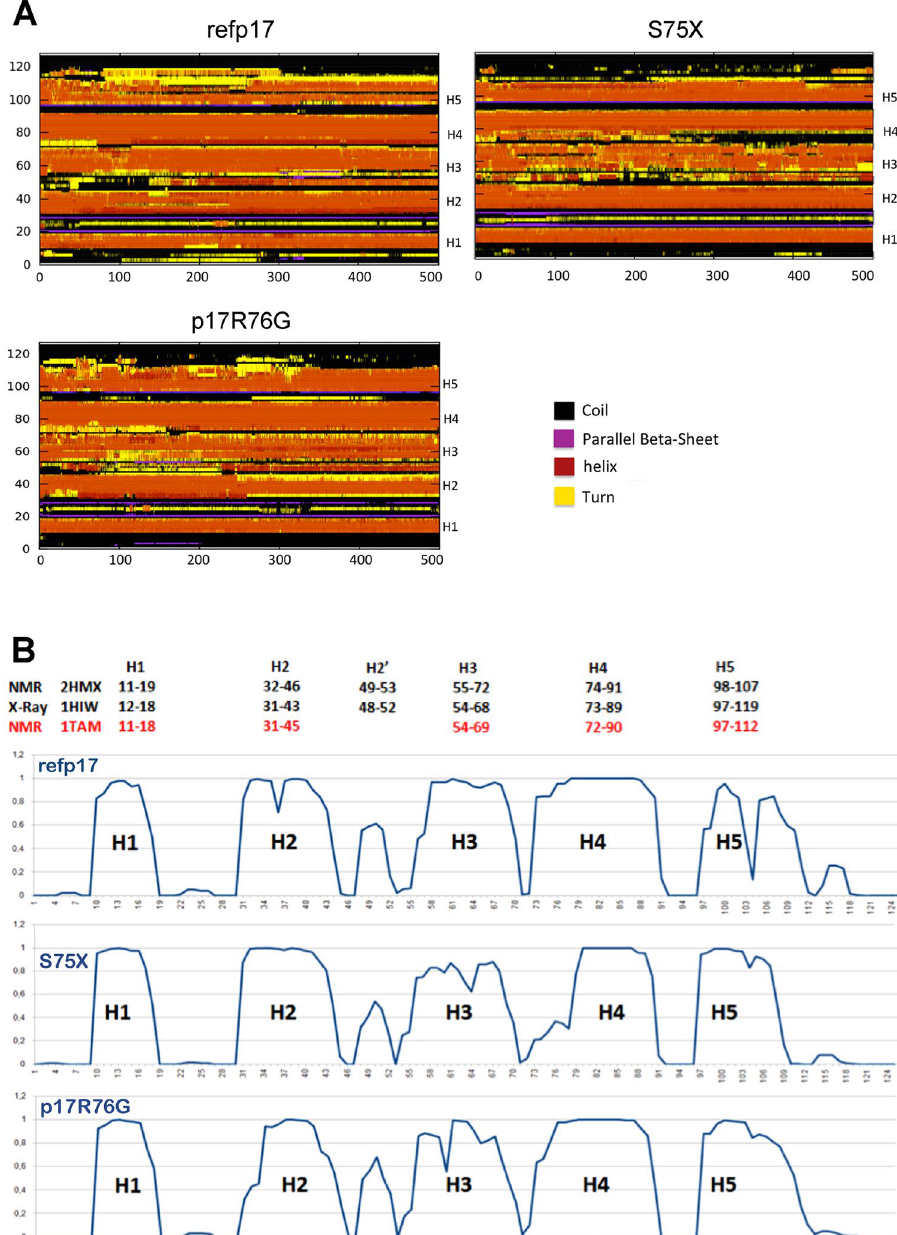
Figure 2. Evolution of refp17, S75X and p17R76G protein structure by molecular dynamics simulations. ( A ) Time evolution of the secondary structural elements along the molecular dynamics simulation generated by DSSP. The X-axis represents the molecular dynamics trajectory time (in ns), while the residue numbers are shown on the Y-axis. ( B ) At the top of the Figure are indicated the residues involved in forming the helix structures of refp17 and determined experimentally by NMR (PDB code: 2HMX and 1TAM) and X-Ray (PDB code: 1HIW). In the graph the propensity for each amino acid residue to assume helix structure calculated during simulations of refp17 and its